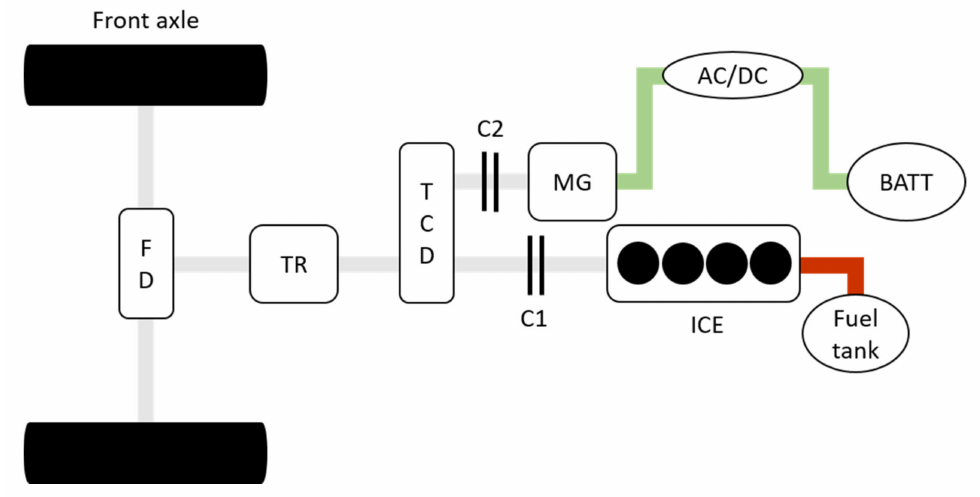
Figure 3. Powertrain configuration of a parallel pre-transmission hybrid electric